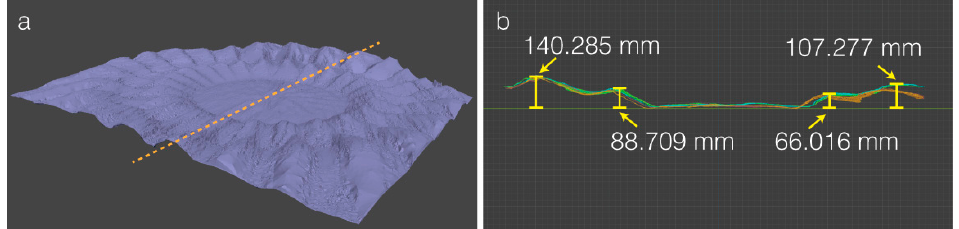
Figure 5. Process used for obtaining nest profile for 2D simulations: ( a ) A thin slice is taken from the polygonal model generated through photogrammetry; ( b ) Side view of the slice is used as a reference sketch of the nest outline. Due to the lack of sufficient video footage, the ridge–valley pairs closest to the camera gave an accurate reconstruction. The outlines of these pairs were obtained and mirrored to create the full nest outline seen.